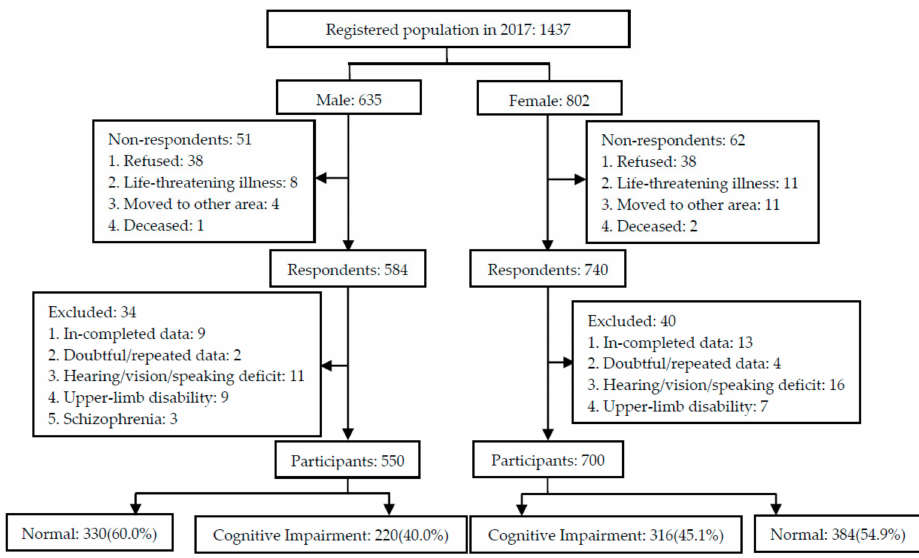
Figure 1. Study flow